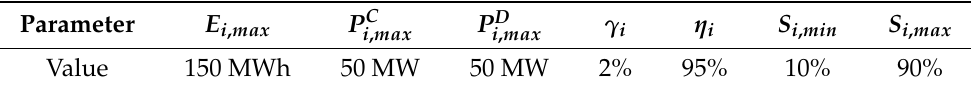
Table 5. Parameters of battery energy storage system (BESS) at bus 7 in Case 2. Data source: [43].